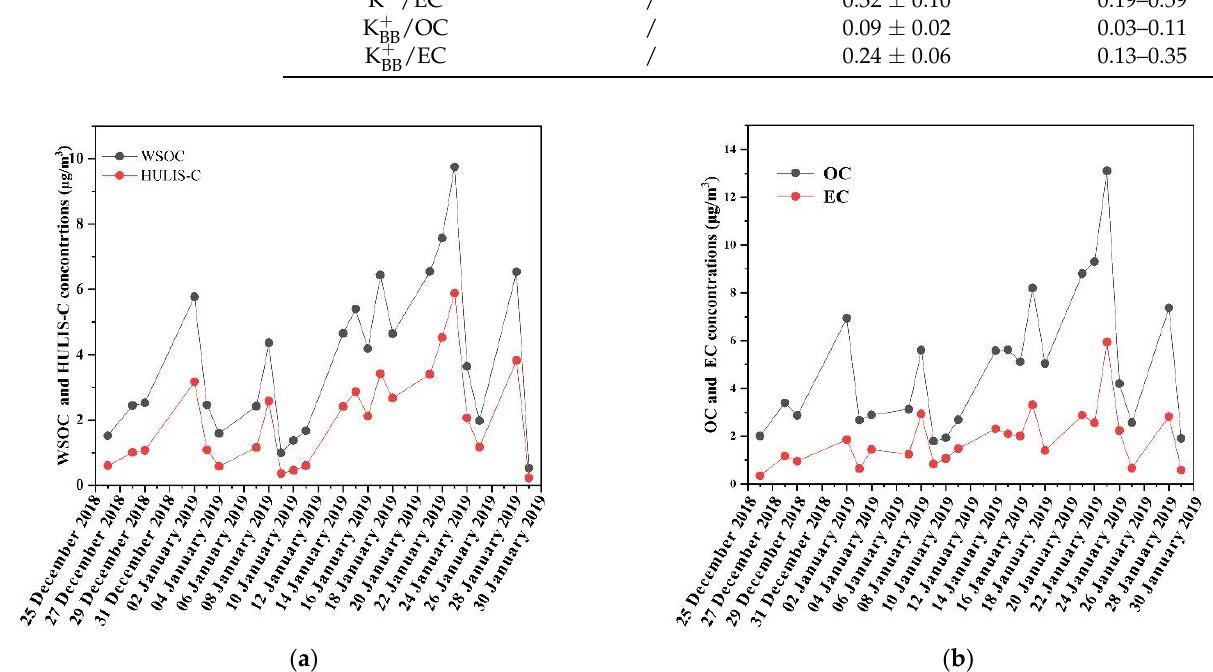
Figure 1. Temporal profiles of carbonaceous species concentrations of ( a ) WSOC and HULIS-C ( b ) OC and